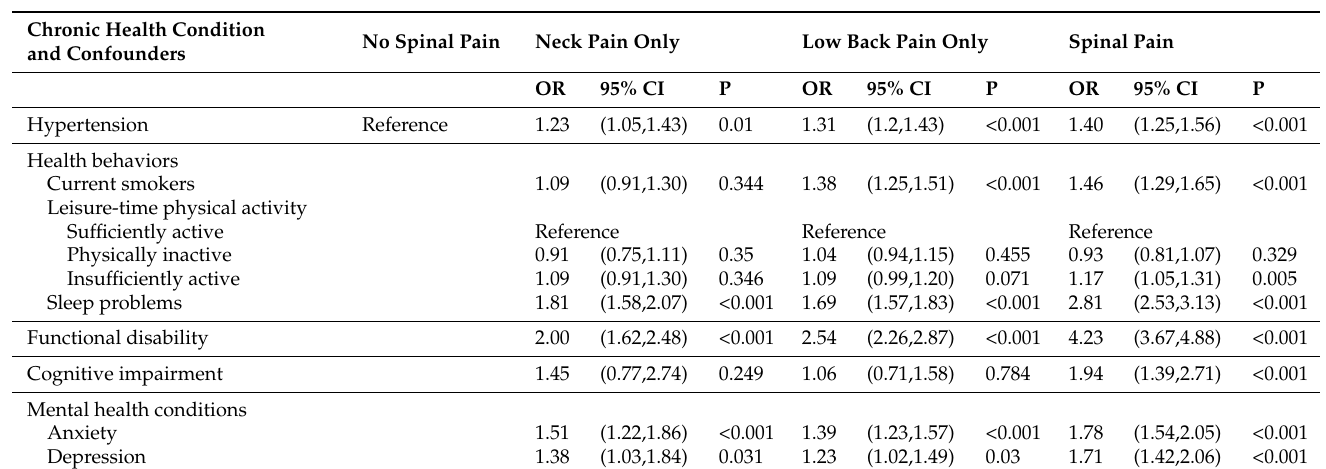
Table 3. The associations between hypertension and spinal pain variables in the US adult population, 2016–2018 *.